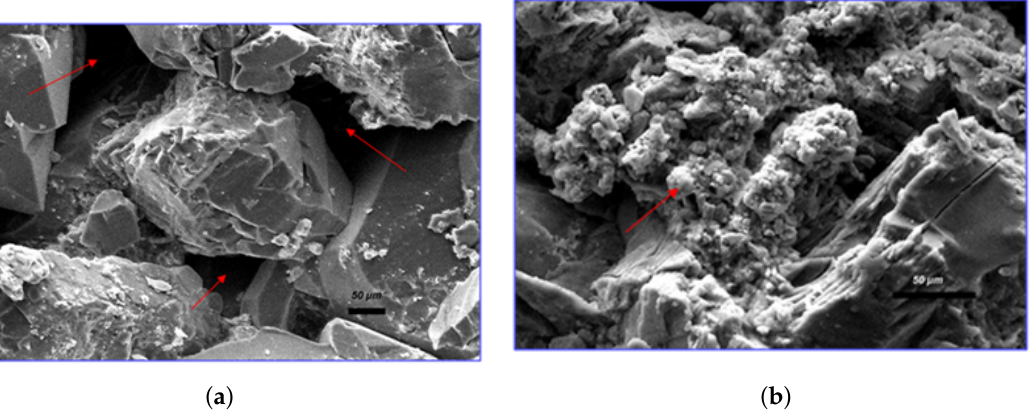
Figure 11. Images from an electronic scanning microscope before and after the fluid circulation ( a ) exhibiting the open pores prior to the fluid injection and ( b ) the mineral salt accumulation following the fluid